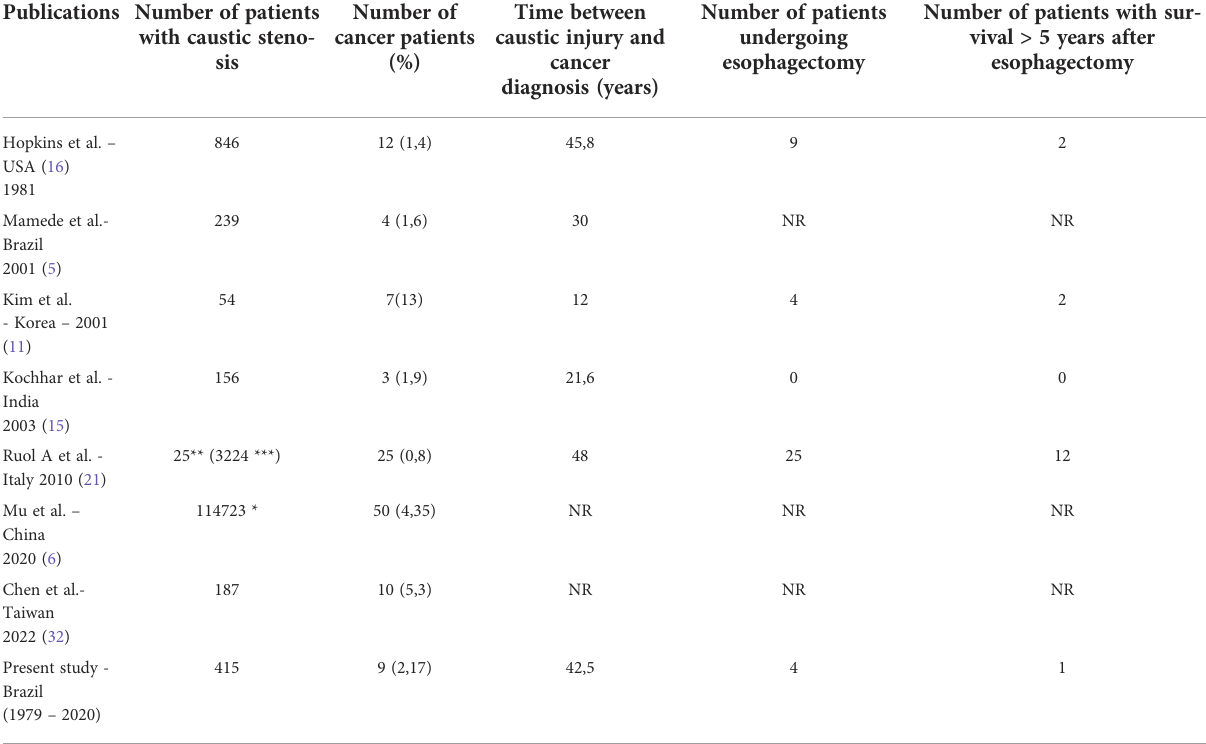
TABLE 1 The authors who recorded the percentages of malignant neoplasms after caustic ingestion. Publications Number of patients with caustic steno-